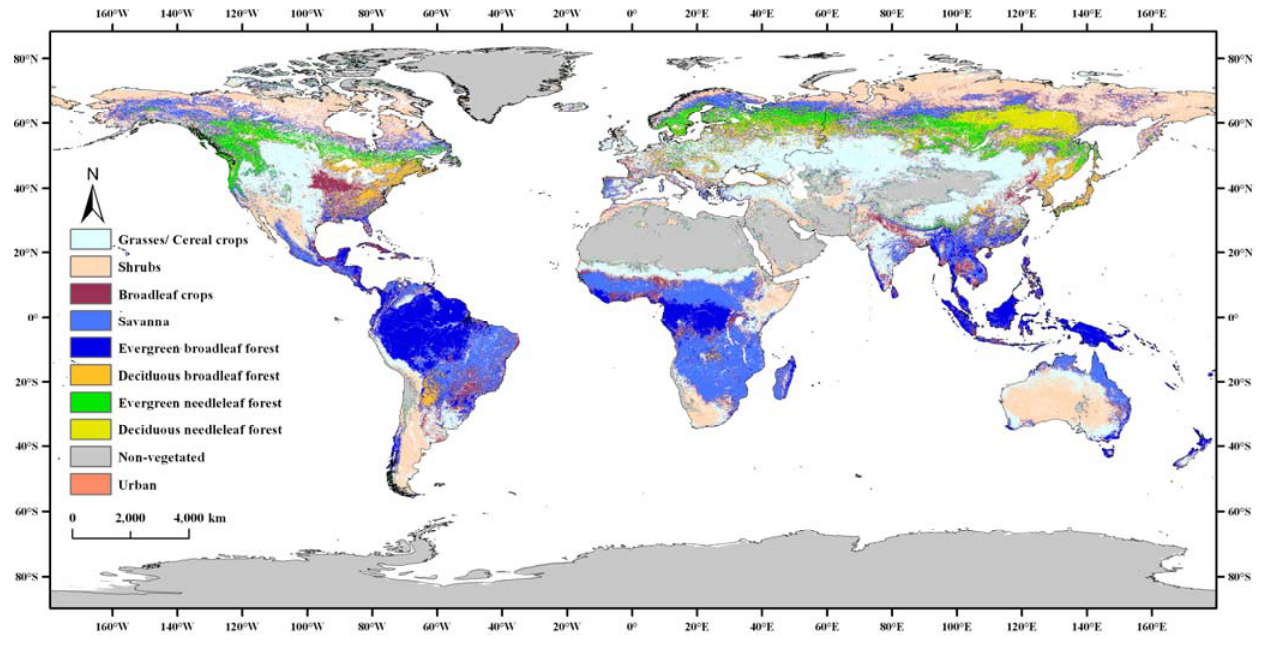
Figure 1. Global distribution of the primary biome types based on the MODIS Leaf Area Index (LAI)/Fraction of Absorbed Photosynthetically Active Radiation (FPAR) (Type 3) classification system. Data from the MODIS (MCD12Q1 C5) land cover product in 2003 (1